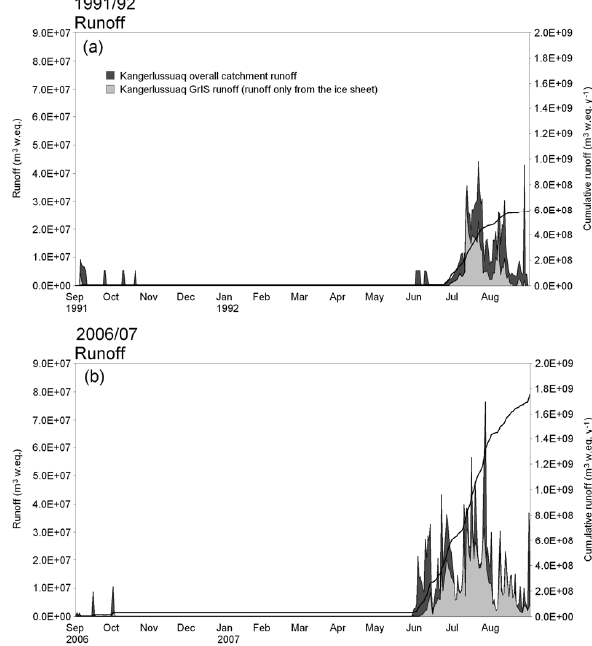
Fig. 4. (a and b) Time series of daily modeled runoff for the Kangerlussuaq part of the Fig. 4. (a) and (b) Time series of daily modeled runoff for the GrIS and for the Kangerlussuaq drainage area for 1991/92 (the year with the lowest Kangerlussuaq part of the GrIS and for the Kangerlussuaq drainage annual cumulative runoff) and 2006/07 (highest cumulative runoff). The period from area for 1991/1992 (the year with the lowest annual cumulative September through August follows the fixed GrIS mass-balance year. runoff) and 2006/2007 (highest cumulative runoff). The period from September through August follows the fixed GrIS mass- balance